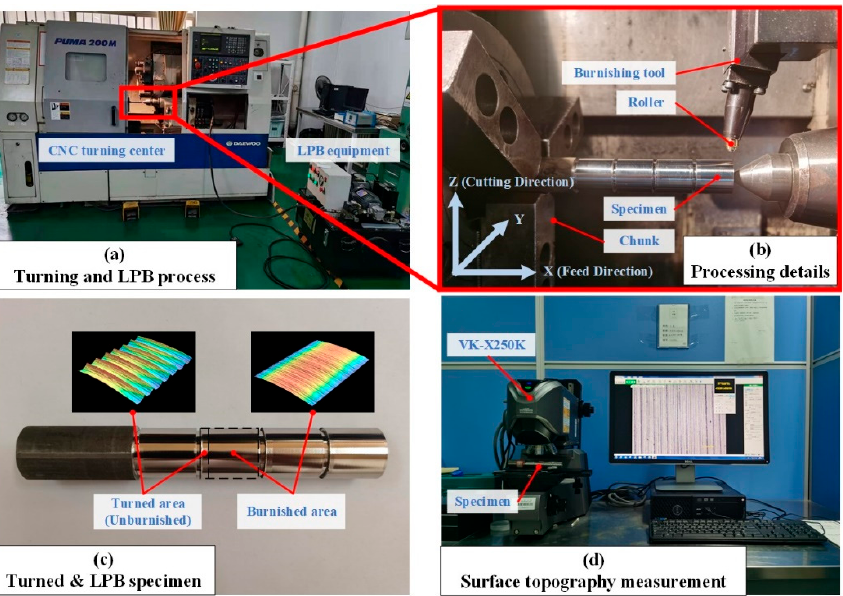
Figure 9. Experimental steps. ( a ) Turning and LPB process and equipment; ( b ) Processing details and the machining coordinate system establishment; ( c ) The specimens after turning and LPB process; ( d ) Surface topography instruments and measurement process.